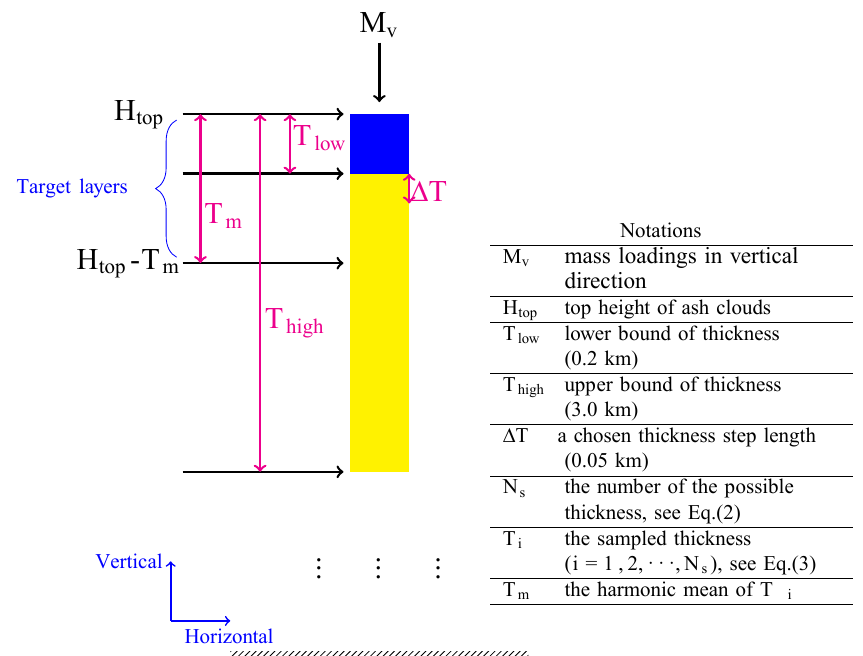
Figure 2. Illustration of the satellite observational operator (SOO).